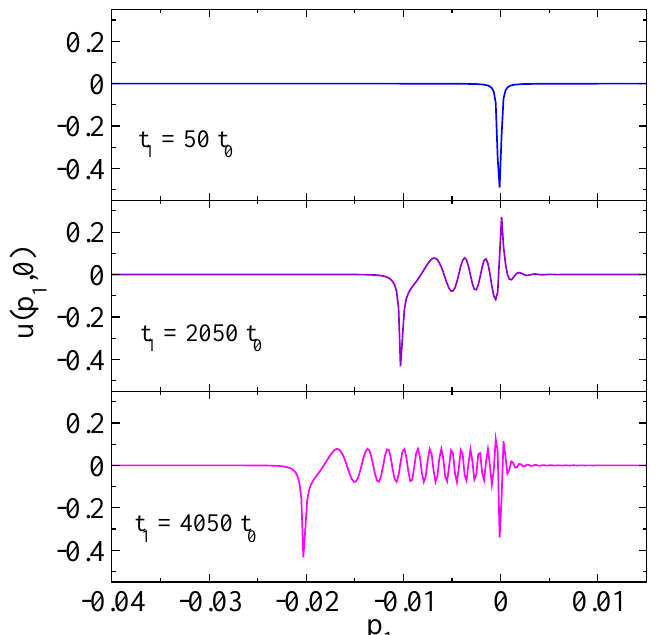
Figure 2. The polarization function u ( p 1 , p 2 = 0 ) for the times: t 1 = 50 t 0 ( 1.23 × 10 − 14 s, upper graph ), t 2 = 2050 t 0 ( 5.043 × 10 − 13 s, middle graph ), t 3 = 4050 t 0 ( 9.963 × 10 − 13 s, lower graph ) in a constant